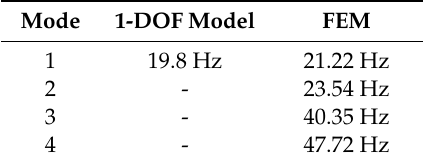
Table 6. Natural frequencies of the system. FEM, finite element method.